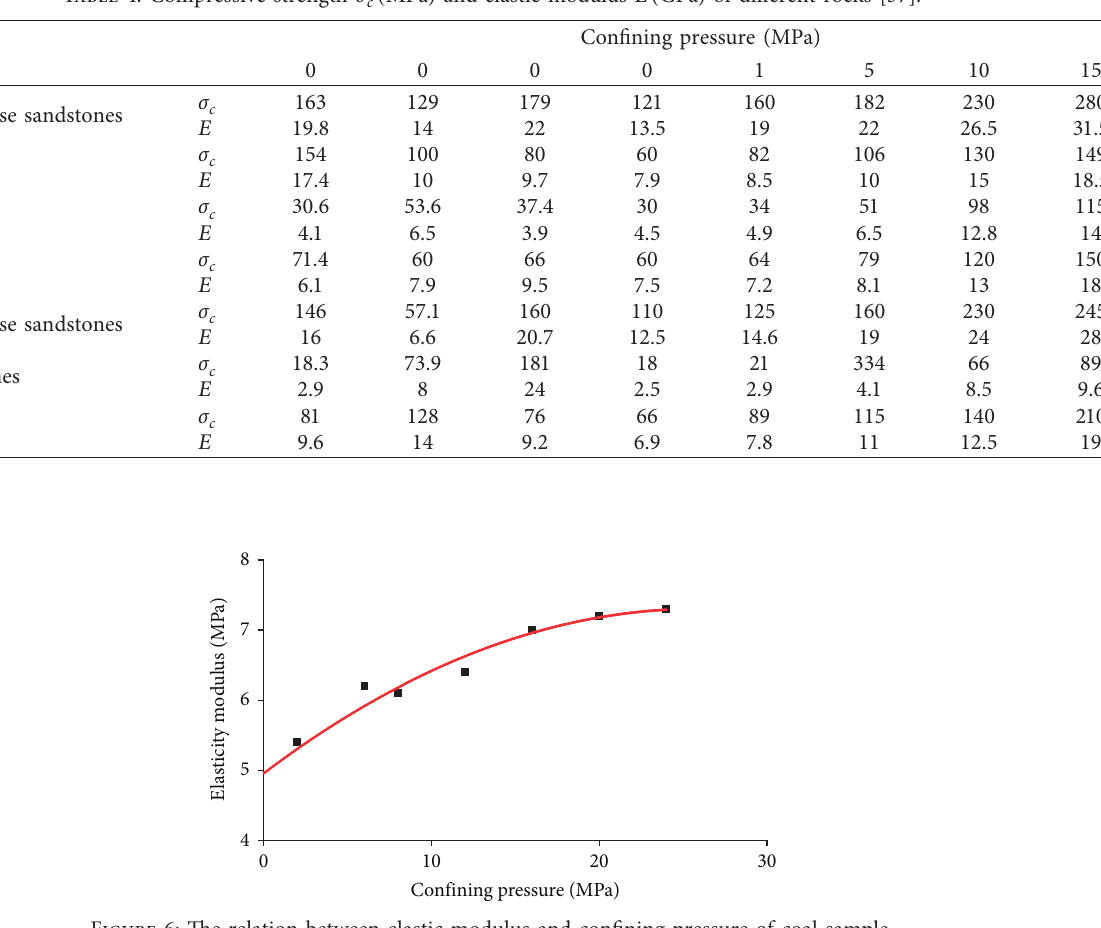
Figure 5: Mechanical model for rockburst based on time-varying structure. Table 4: Compressive strength σ ( MPa ) and elastic modulus E ( GPa ) of different rocks [37]. c